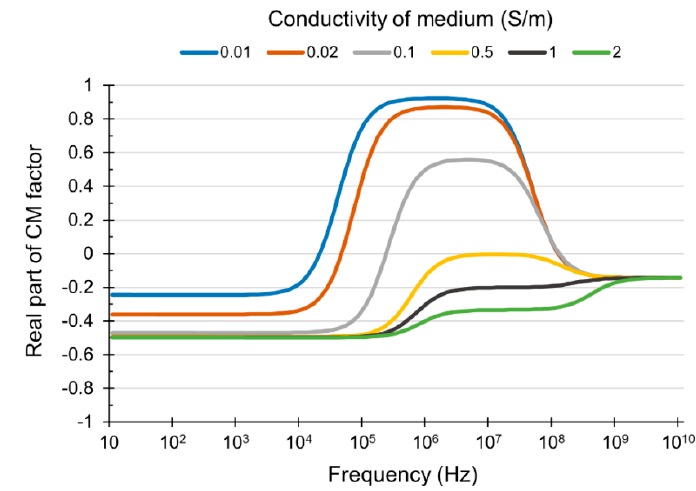
Figure 5. The relationship between the conductivity of the dielectrophoresis (DEP) medium and the